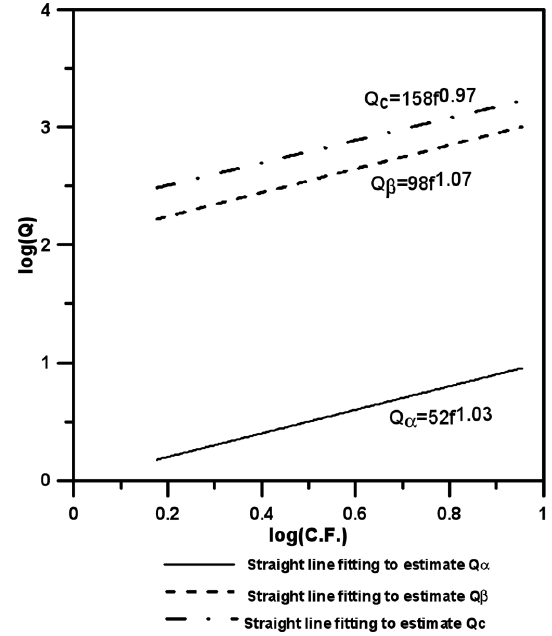
Table 3. Values of different quality factors estimated at different central frequencies.